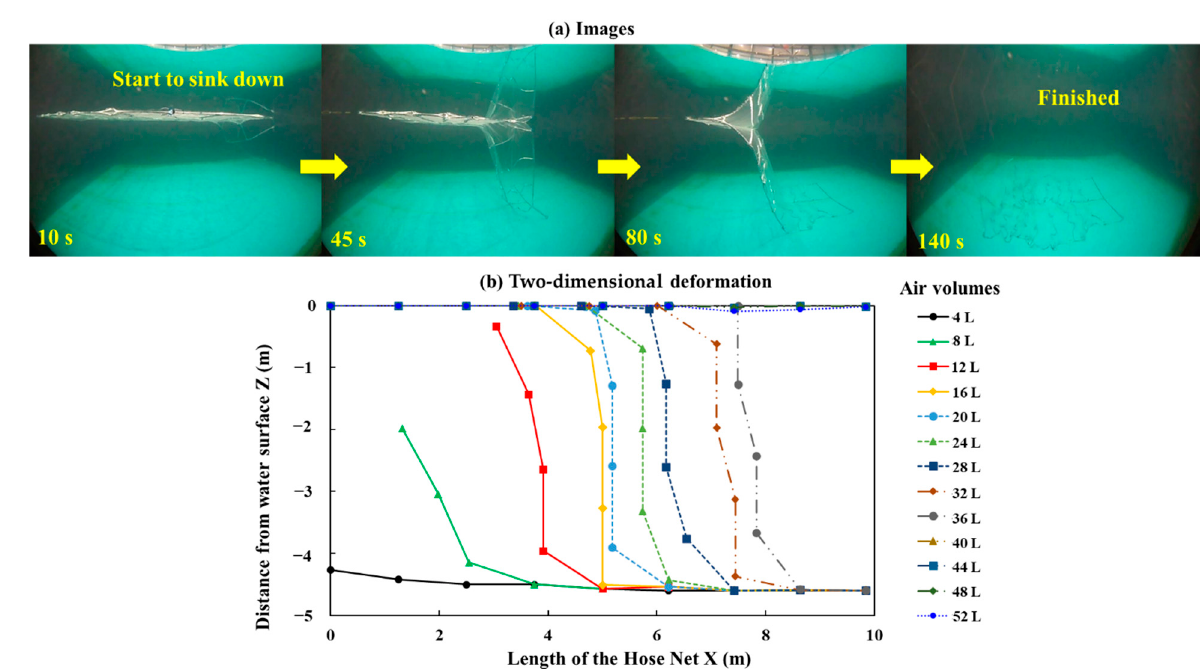
Figure 10. ( a ) Time-series images during the sinking down the process. ( b ) Two-dimensional deformation with different volumes of air in the sinking up process.